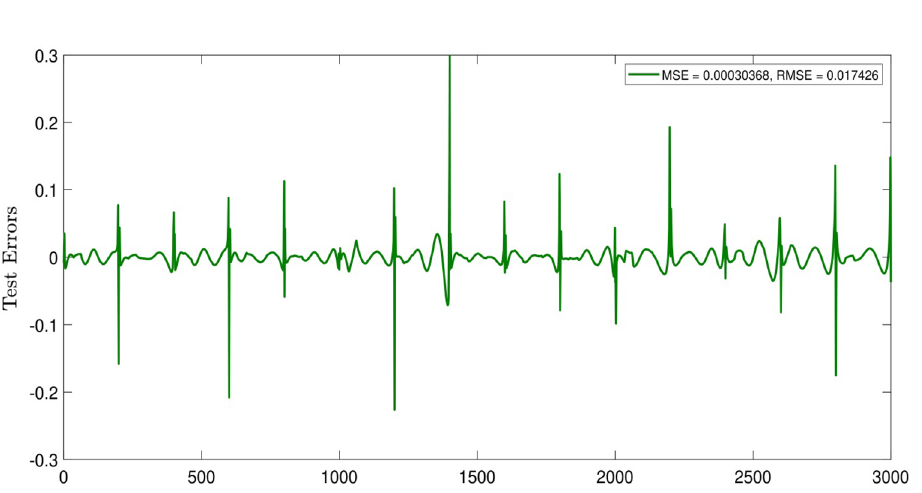
Figure 7. Test_ErrorsnewACO, nIP = 5, CIR = 0.5, ndata = 3000, Subtractive, MaxEpoch = 70, P = 75, nant = 20, q = 0.2, CIR =